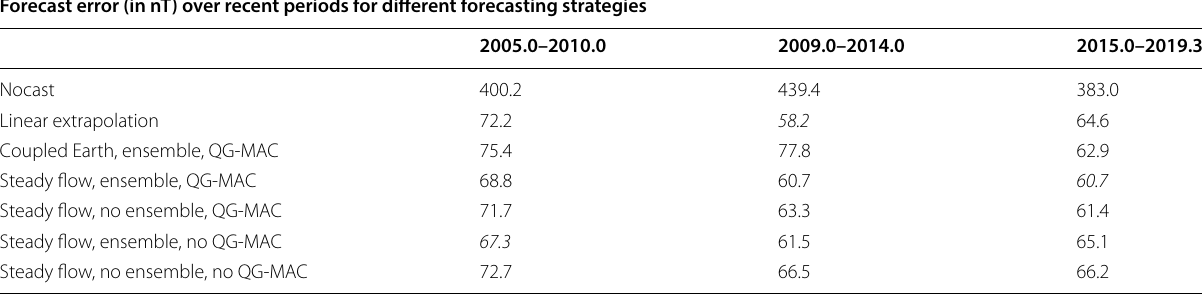
Italics values indicate the best strategy for each period Nocast assumes that the field does not change. Linear extrapolation assumes a linear variation whose slope is specified by the secular variation up to degree 13 at the start of the forecast period, as specified by the initial field model we construct; “Coupled Earth, ensemble, QG-MAC” indicates that the full coupled Earth dynamo model is integrated for the 100 ensemble members, with the median defining the forecast, and an initialization where the QG-MAC constraint is mildly enforced. In the last four rows, “‘Steady flow” implies that the sole three-dimensional induction equation (with magnetic diffusion) is integrated, with or without an ensemble approach, and with or without the mild imposition of the QG-MAC constraint. If an ensemble approach is adopted, it is the median that defines the forecast